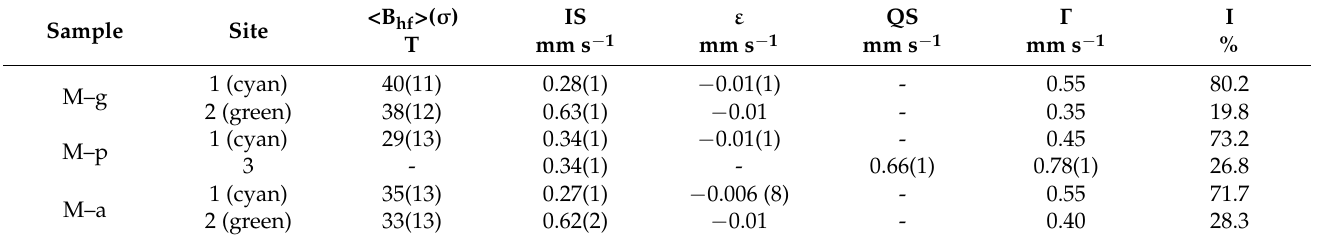
Table 5. Mössbauer hyperfine fitting parameters for NP M g, M p and M a. <B hf >( ): average mag ‐ netic hyperfine field and standard deviation of the magnetic field distribution; IS: isomer shift; : quadrupole shift; : Lorentzian line width; I: relative area. Uncertainties in I are less than 2%. Table 6. Mössbauer hyperfine fitting parameters for NP M–pg and M–pa. <B hf >( σ ): average mag- netic hyperfine field and standard deviation of the magnetic field distribution; IS: isomer shift; ε : quadrupole shift; Γ : Lorentzian line width; I: relative area. Uncertainties in I are less than